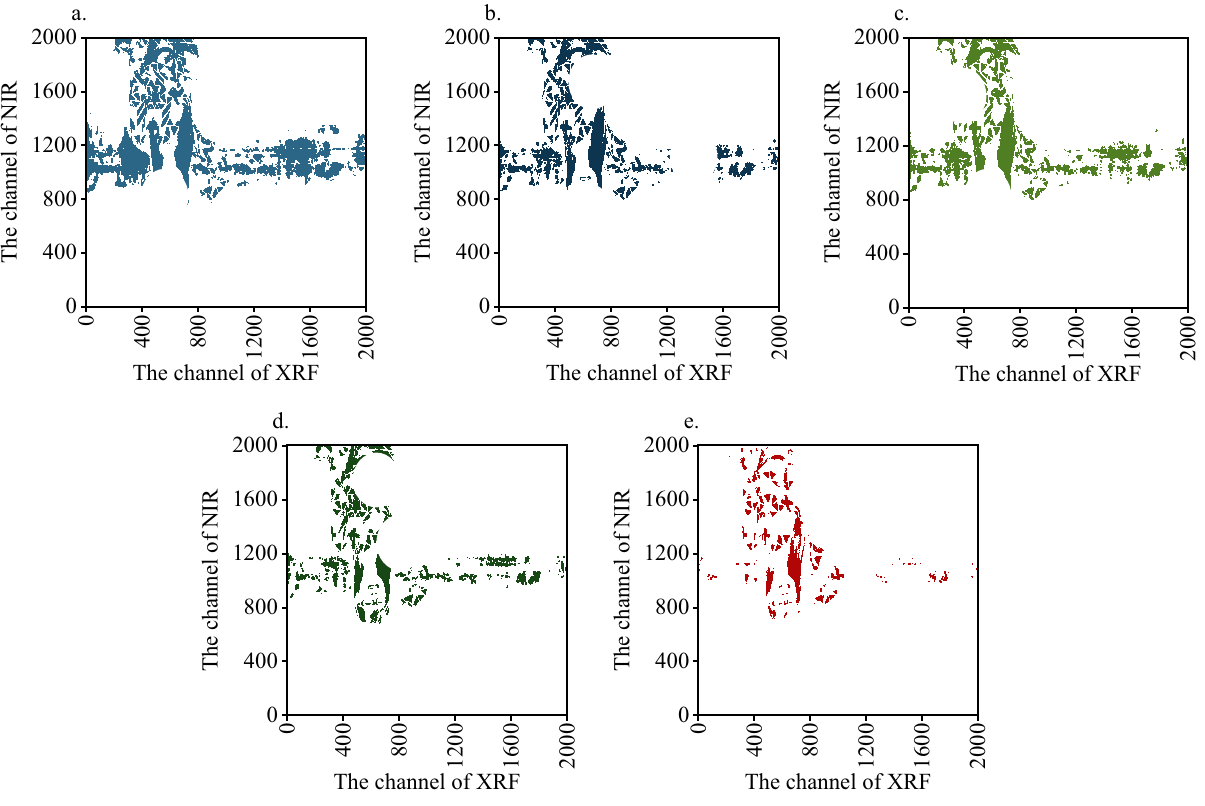
Figure 6. The feature selection of Ca OPA spectral distribution, ( a ) LAR, ( b ) SPA, ( c ) MC-UVE, ( d ) CARS, ( e )